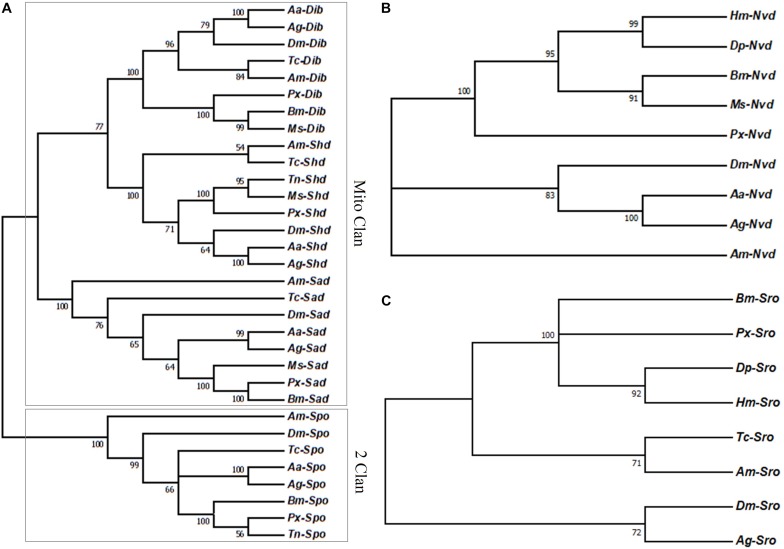
(A) Phylogenetic relationships of the Halloween genes encoding P450 enzymes, (B)
Nvd, and (C) Sro between P. xylostella and the other insects. Aa, Aedes aegypti; Ag, Anopheles gambiae; Am, Apis mellifera; Bm, Bombyx mori; Dm, Drosophila melanogaster; Dp, Danaus plexippus; Hm, Heliconius Melpomene; Ms, Manduca sexta; Px, Plutella xylostella; Tc, Tribolium castaneum; Tn, Trichoplusia ni.